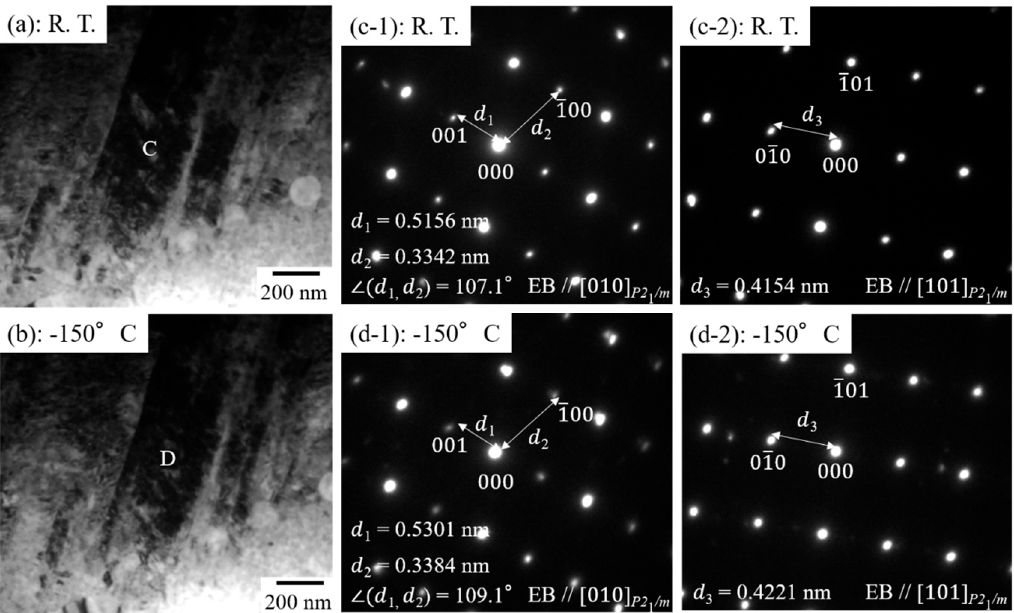
Figure 8. ( a , b ) Bright field images of 10th cycled equiatomic CuZr alloy at R. T., and − 150 °C, and ( c - 1,2)-( d -1,2) electron diffraction patterns taken from the martensitic variants C in ( a ), and D in ( b ), respectively. (The measured maximum temperature at DSC measurement is 500 °C).